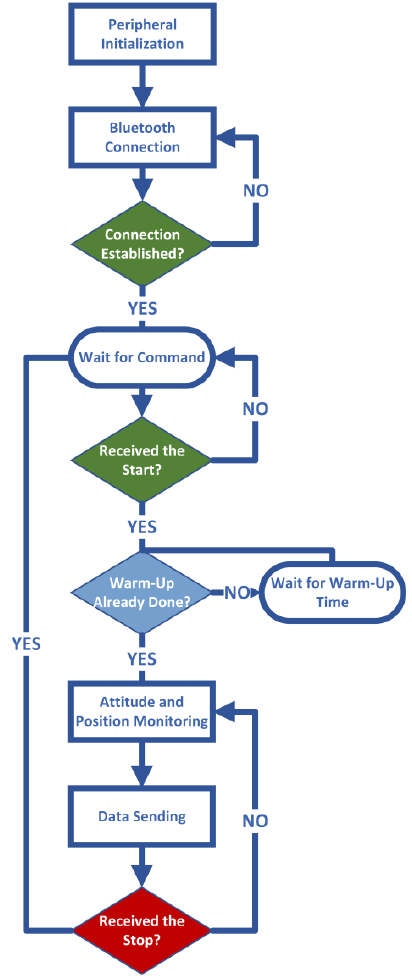
Figure 3. Microcontroller program flow chart. The core system communicates with the ADIS16495 through the SPI protocol and with GPS and Bluetooth modules by means of two UART connections Moreover, in order